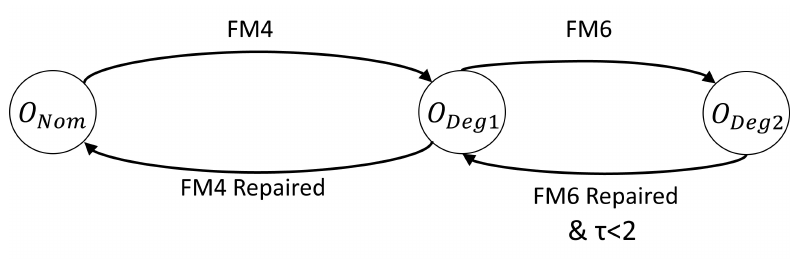
Figure 14. Behavioral modes of the Agent Operator.